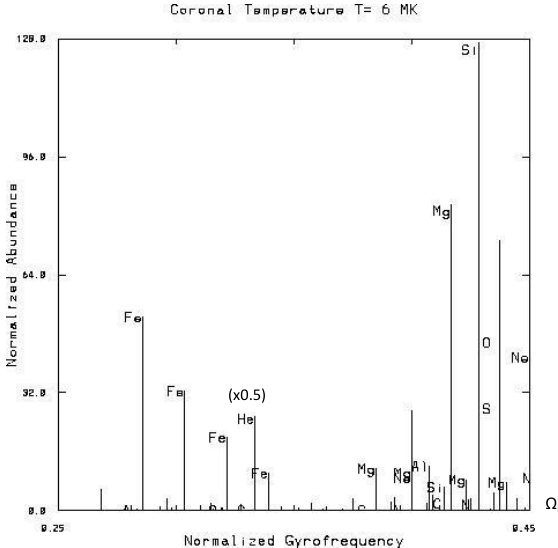
Fig. 3. Distribution of coronal elements as a function of ion gyrofre- Figure 3. Distribution of coronal elements as a function of ion gyrofrequency Ω i (normalized to H) at the temperature of 6 MK; He denotes the isotope 3 He at 0.5 of its gyrofrequency.. Abundances of heavier ions are quency (cid:127) i (normalized to H) at a temperature of 6MK; He denotes spread in gyrofrequencies according to the charge states distributions at a given coronal temperature. the isotope 3 He at 0.5 of its gyrofrequency. Abundances of heav- ier ions are spread in gyrofrequencies according to the charge states 4 Abundance Anomalies in Planetary Nebulae distributions at a given coronal The initial abundance of light elements is determined through the big bang nucleosynthesis (BBN), while measurements of the spatial distribution of elemental abundances provide key constraints for our understanding of Galactic chemical evolution. This evolution is crucial in imposing bounds on the main BBN parameter: baryon-to-photon ratio η b . The 4 He recombination lines in metal-poor galaxies (Peimert & Torres-Peimbert, 1974), resonance lines of 7 Li in metal poor halo stars - resulting in the “Spite plateau” (Spite & Spite, 1982), Lyman series absorption lines of D in metal poor halo QSO (Tytler et al 1996), as well as 3 He + hyperfine singlet-to-triplet transition (Rood et al, 1979; Bania et al, 2007) at 8.665GHz (3.46 cm) in H II regions allow to estimate the η b bounds, i.e. to constrain the baryon density of the Universe. Hence, 3 He can be also used as a “baryometer” (e.g., Yang et al., 1984].